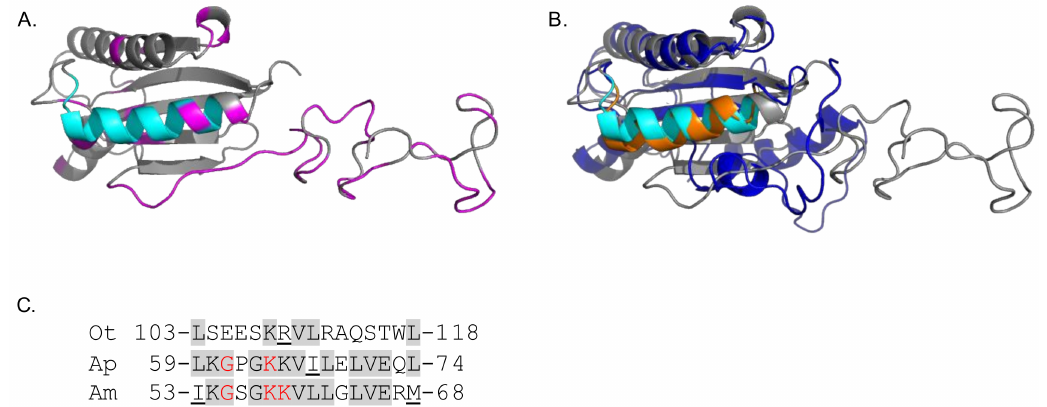
Figure 4. Molecular modeling of O. tsutsugamushi OmpA reveals structural similarity with A. phagocytophilum OmpA and conservation of residues that are critical for Anaplasma spp. OmpA function. ( A ) Predicted tertiary structure for O. tsutsugamushi OmpA. The OmpA mature protein sequence was predicted using the PHYRE 2 algorithm. The cyan portion corresponds to residues 103 to 118, which are analogous to residues 59 to 74 and 53 to 68 of A. phagocytophilum and A. marginale OmpA predicted tertiary structures, respectively, that form receptor-binding domains. Magenta residues are those that vary among the 51 O. tsutsugamushi OmpA sequences studied herein. ( B ) Overlay of O. tsutsugamushi and A. phagocytophilum predicted OmpA tertiary structures. A. phagocytophilum OmpA residues are labeled dark blue except for residues 59 to 74 (labeled orange) that lie within a surface-exposed alpha helix and constitute the receptor binding domain. O. tsutsugamushi OmpA residues are labeled gray except for residues 103 to 118 (labeled cyan) that are analogous to A. phagocytophilum OmpA residues 59 to 74. ( C ) Alignment of O. tsutsugamushi (Ot) OmpA residues 103 to 118, A. phagocytophilum (Ap) amino acids 59 to 74, and A. marginale (Am) residues 53 to 68. Identical residues among the three sequences are shaded gray. Similar amino acids are underlined. Functionally essential residues in the Anaplasma spp. OmpA proteins are in red